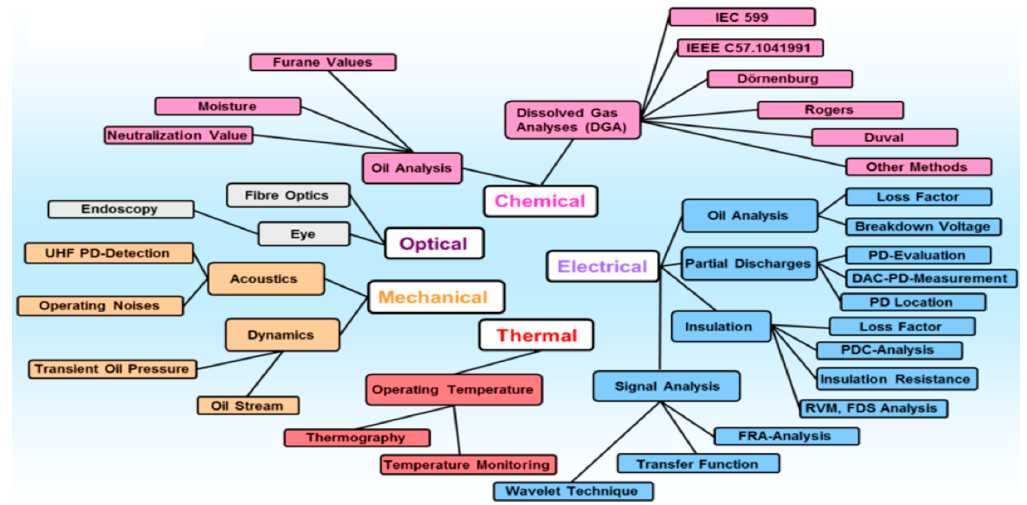
Figure 1. Examples of monitoring and diagnostic methods for evaluating the condition of an oil-filled power transformer [4].